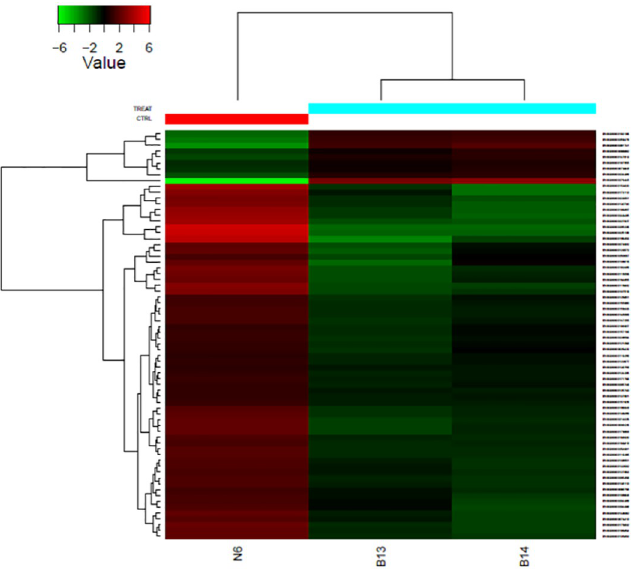
Fig 1. Heat map graph comparing the fold values of the 70 differentially expressed sequences in each sample. Values above the normalized reference value (Z score) are shown in green, the reference value is shown in red, and values close to the reference are represented by a dark tone. Each column represents a sample, and each row represents a sequence. N6, control tissue; B13 and B14, goiter tissues.